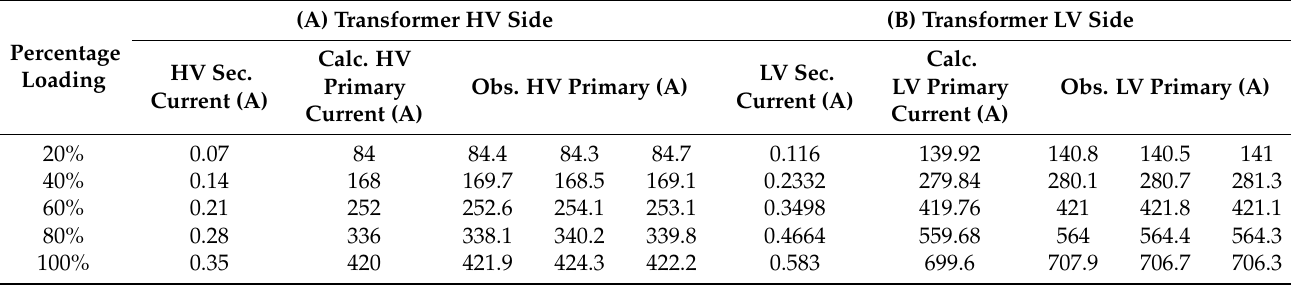
Figure 6. Three phase balanced current injection and resulting differential and bias currents in per unit (pu) for: ( a ) HV nominal secondary and ( b ) LV nominal secondary. Table 5. Primary current observed by relay for different percentage loading of: ( A ) transformer HV side in terms of HV secondary current and ( B ) transformer LV side in terms of LV secondary